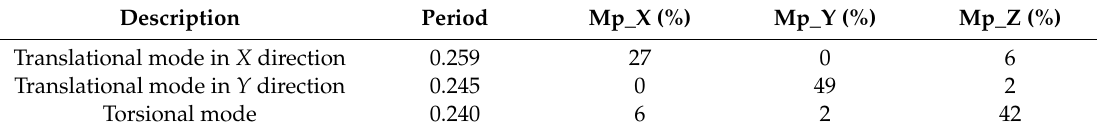
Table 2. Periods and modal participating mass ratios of the case study.